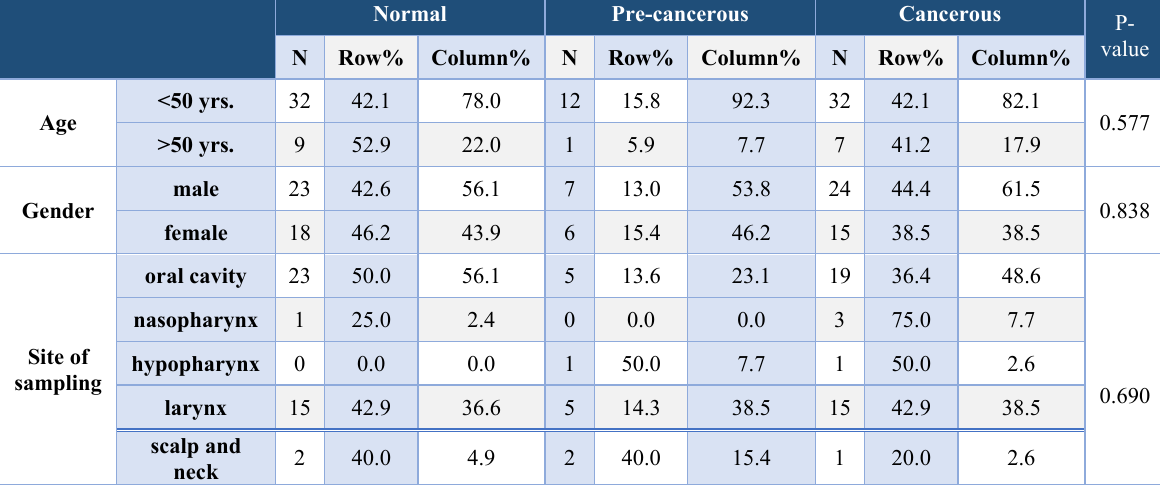
Table 2 . Evaluation of frequency distribution of clinical characteristics of patients